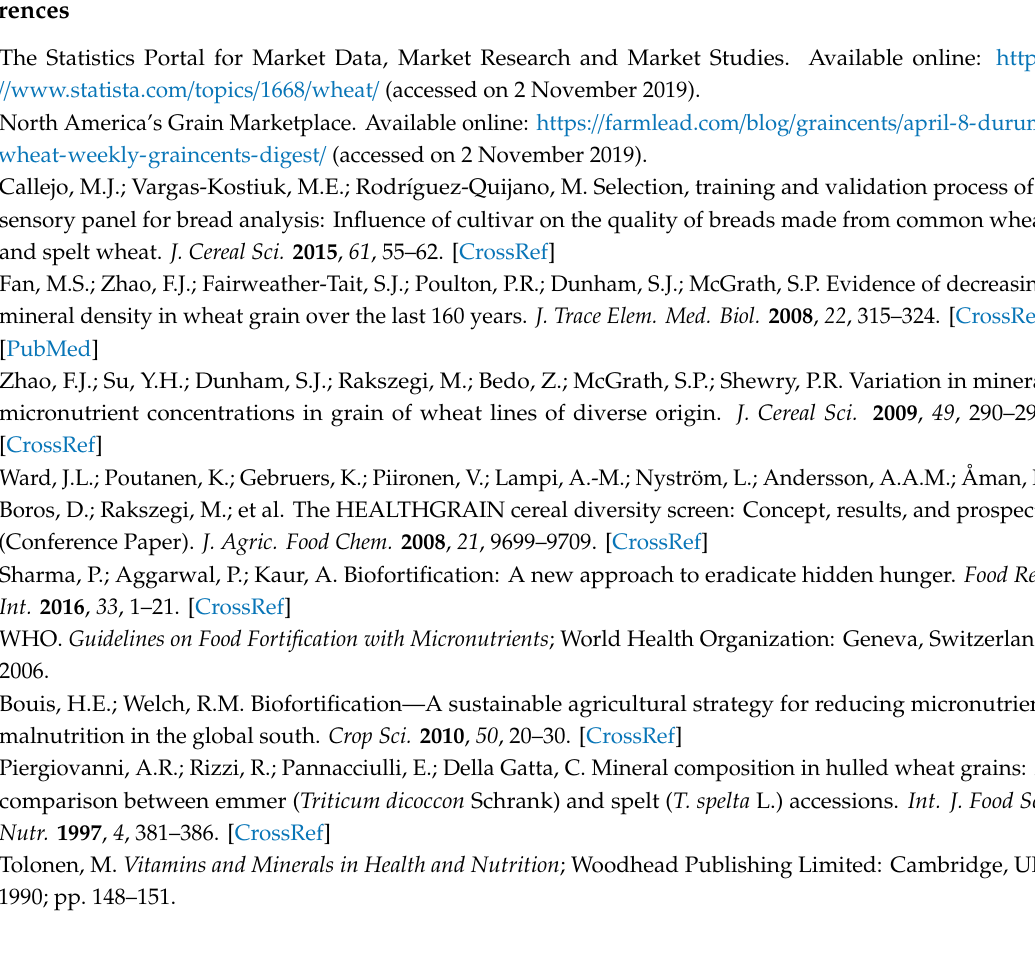
Table S1: Concentrations of elements ( µ g g − 1 ) in the soil under the field